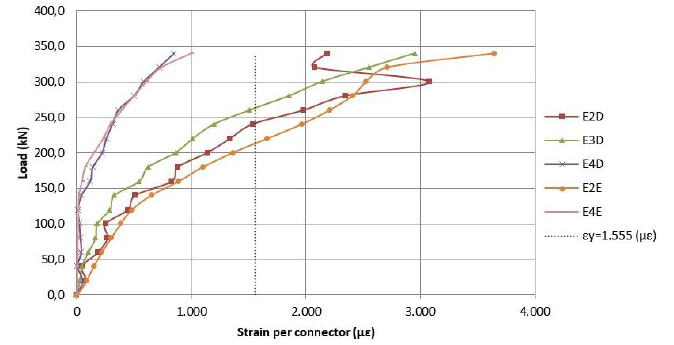
Figure 27. Load x strain per connector curve – V1A.